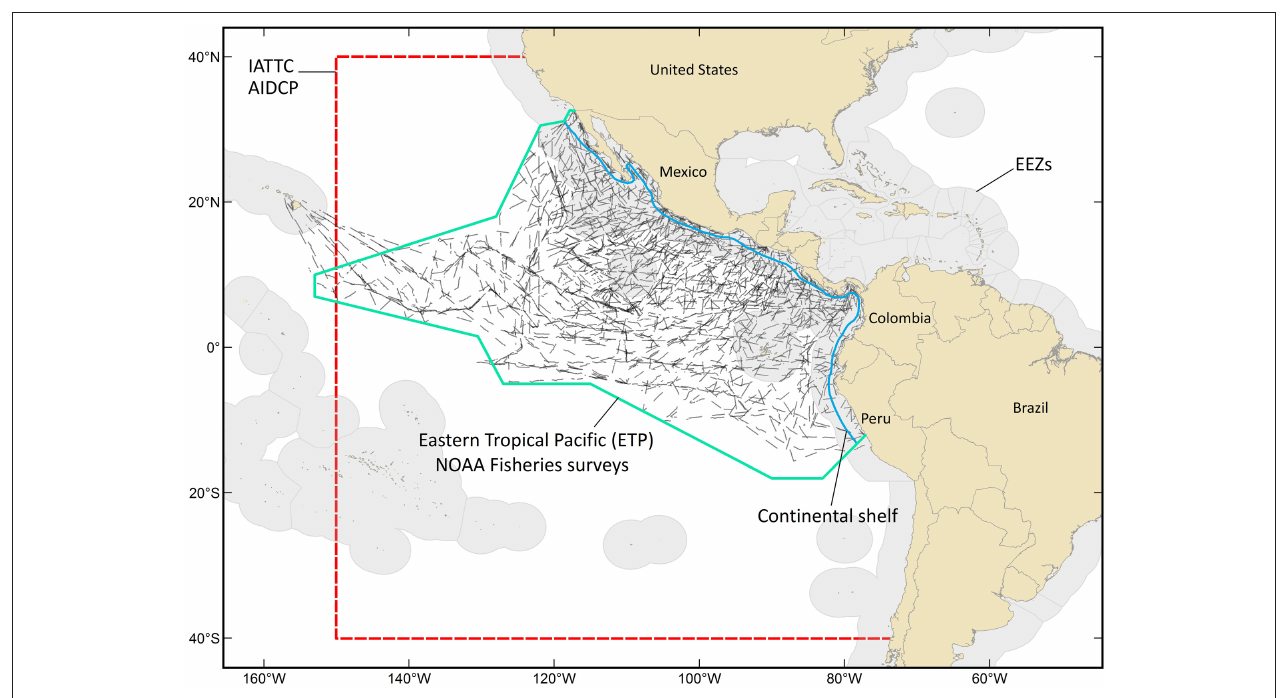
FIGURE 1 | The oceanic eastern tropical Pacific (ETP) is defined as the area seaward of the continental shelf, from the Americas west to approximately 150 ◦ longitude, and from the U.S.-Mexico border south to central Peru. This area is roughly 21 million km 2 , includes waters of 12 nations (Exclusive Economic Zones (EEZs) are shaded light gray) and the oceanic commons, and roughly corresponds to the area managed by two regional fishery management bodies: the Inter-American Tropical Tuna Commission (IATTC) and the Agreement on the International Dolphin Conservation Program (AIDCP). The area managed by the IATTC is outlined with a red hashed line; this is also the relevant area for AIDCP. The black segmented lines are ship tracklines from NOAA Fisheries surveys (1986–1990, 1998–2000, 2003, 2006). These surveys were conducted to assess populations of dolphins historically impacted by the tuna purse-seine fishery.